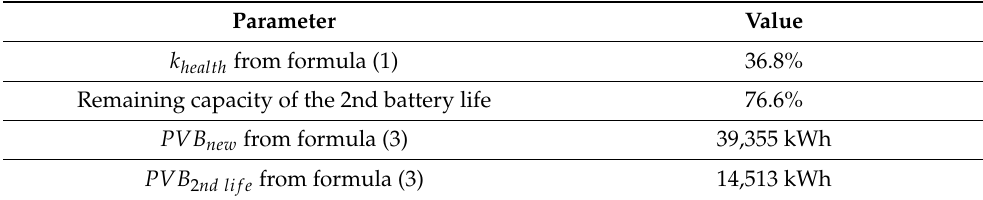
Table 6. Input values for the calculation of the 2nd battery